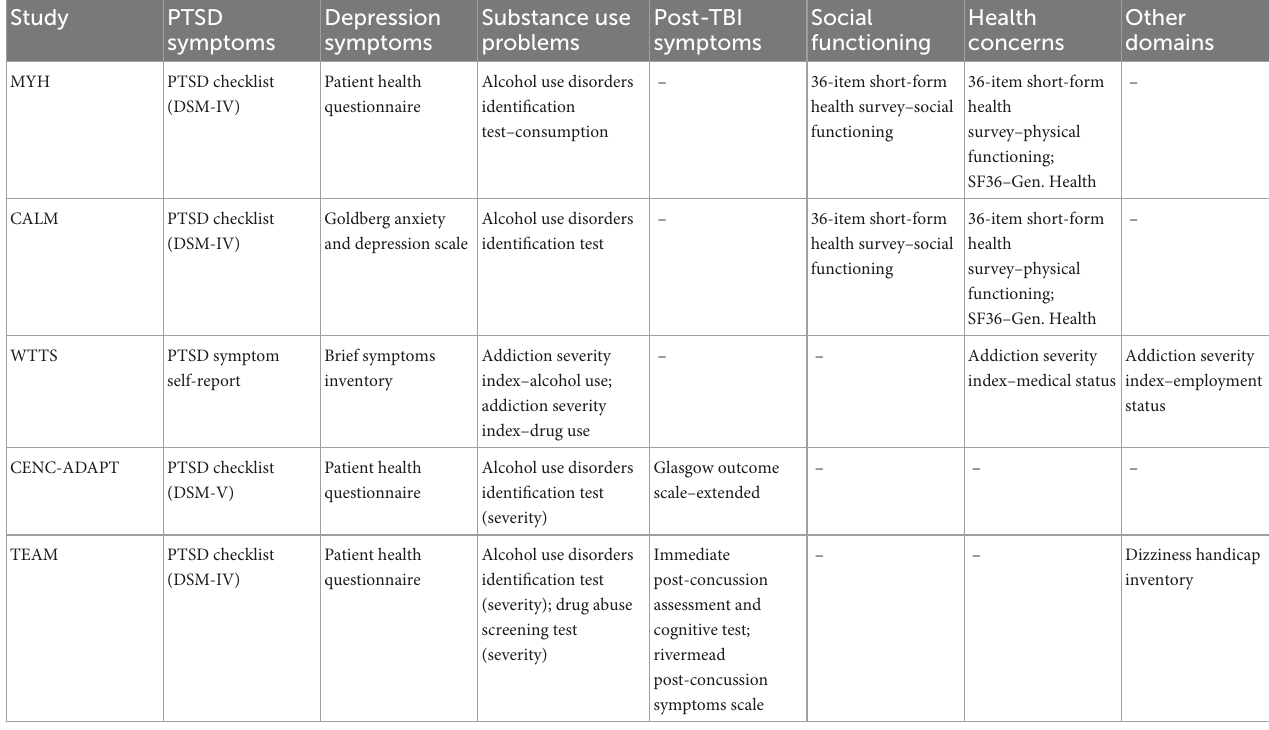
TABLE 1 Measures included in each study